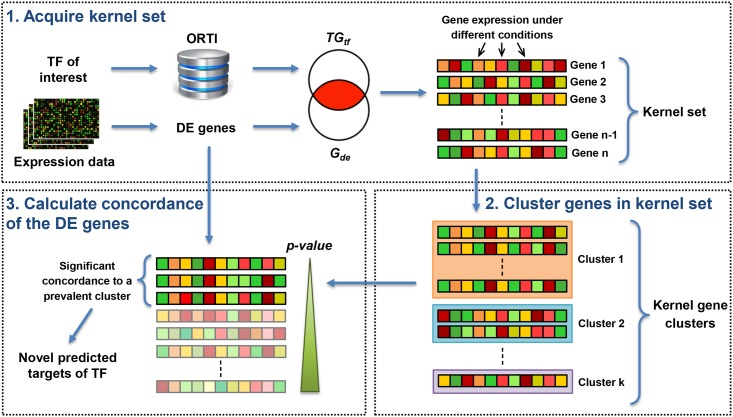
The pipe-line for Application II, the prediction of novel TF-TG interactions.Details are provided in the Materials and Methods. Abbreviations: TF, transcription factor; DE, differentially-expressed; TGtf, Rank 1 target genes connected to the TF of interest within the ORTI database; Gde, subset of DE genes; KSC, kernel set concordance. Figure design partially adapted from [38].